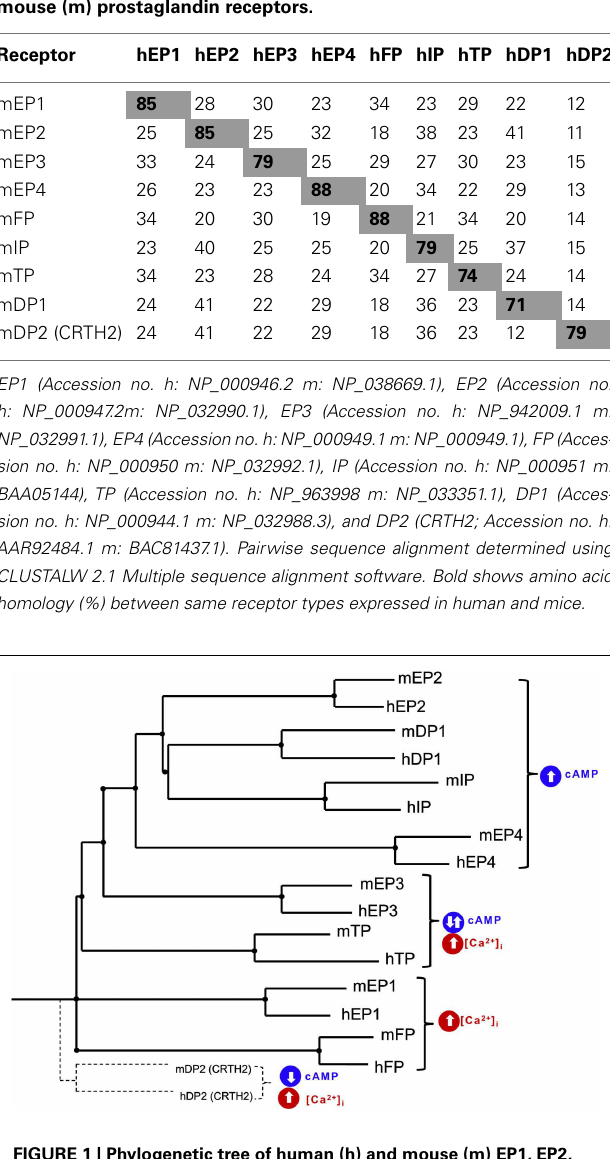
FIGURE 1 | Phylogenetic tree of human (h) and mouse (m) EP1, EP2, EP3, EP4, FP, IP,TP, DP1, and DP2 (CRTH2) receptors. Tree was constructed using pairwise sequence alignment determined using CLUSTALW 2.1 Multiple sequence alignment software and presented as NJplot. Evolutionally conserved prostaglandin receptors can be grouped into signaling pathways: cAMP stimulating and calcium